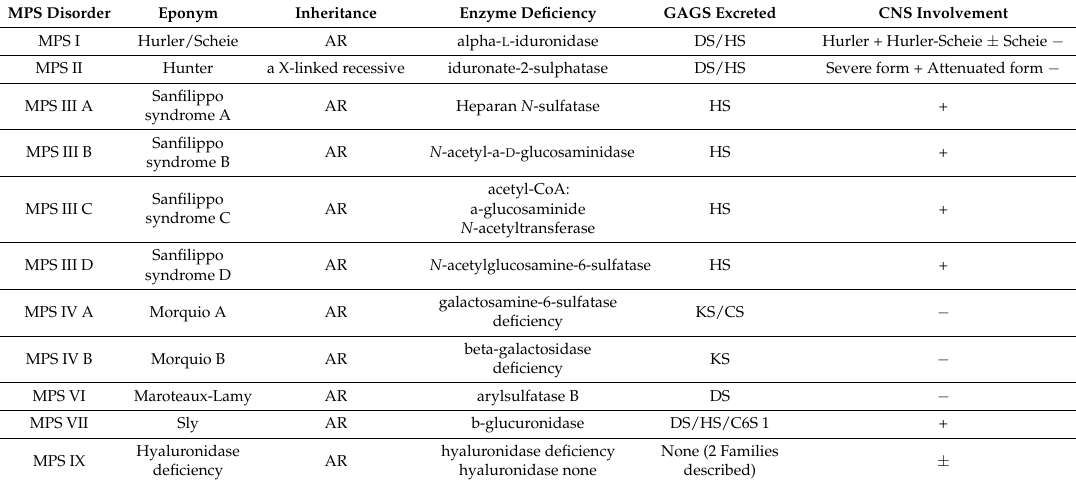
Table 1. Mucopolysaccharidoses (MPSs) from I to IX and their modality of inheritance, type of enzyme deficiency, and cosaminoglycans (GAGs) excreted and central nervous system (CNS)